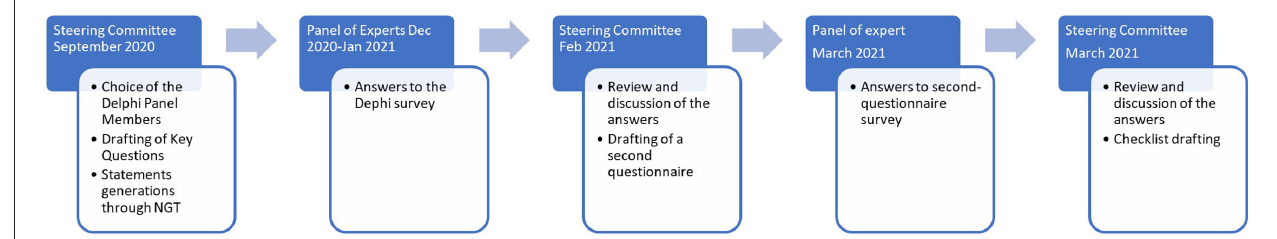
FIGURE 1 | Project